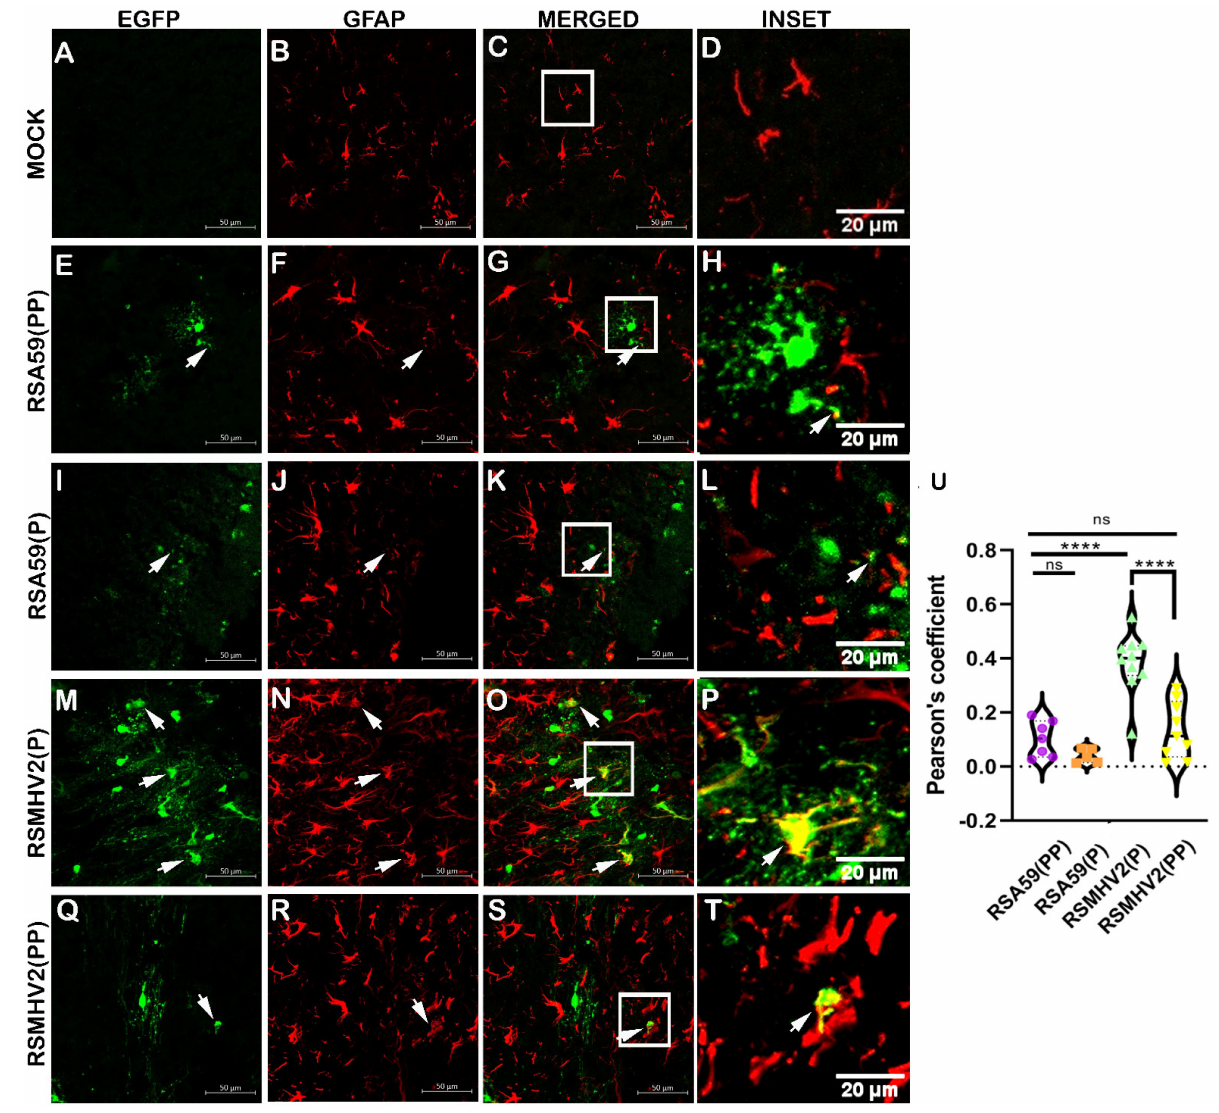
Figure 6. Colocalization of parental strains RSA59(PP), RSMHV2(P), one proline deleted RSA59(P), and one proline added RSMHV2(PP) mutants infected cells within astrocytes in the brain of mice at day 5 p.i. Cryosections of infected mouse brains and mock-infected mice were immunofluorescently labeled with GFAP ( B , F , J , N , R ). EGFP denotes infected cells in Panel ( E , I , MQ ) and mock-infected brain in panel A. Representative merged images of EGFP and GFAP channels ( C , G , K , O , S ) show colo- calization of EGFP and GFAP-positive cells with arrowheads highlighting virus infected astrocytes. Mock sections are in Panel ( A – D ), RSA59(PP) infected sections are in panel ( E – H ), RSA59(P) infected sections are in Panel ( I – L ), RSMHV2(P) infected sections are in Panel ( M – P ), and RSMHV2(PP) infected sections are in Panel ( Q – T ). The insets marked by a white rectangle area in the merged panels show an area of magnified view of the colocalization of the astrocyte with EGFP (seen as yellow). Quantification of colocalization of astrocytes with the virus as the Pearson coefficient was done and plotted in a violin diagram ( U ). The One-way ANOVA is used to compare RSA59(PP) with RSA59(P), RSMHV2(P), RSMHV2(PP) and RSMHV2(P) with RSMHV2(PP). The level of significance was taken at, p < 0.05, **** p < 0.00001, and ns denotes